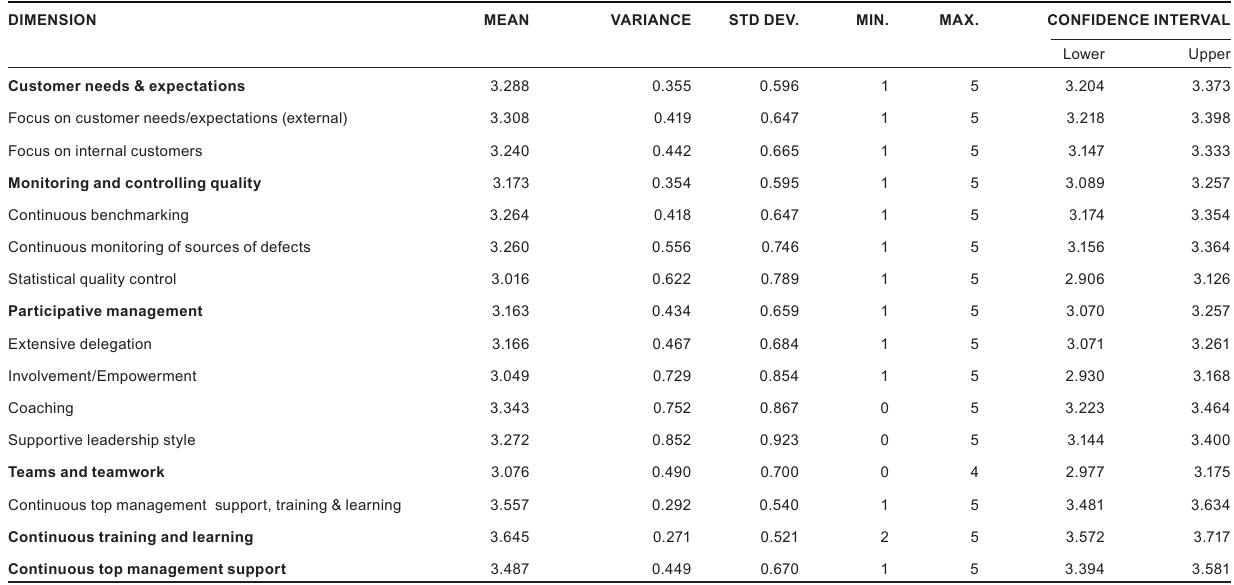
Table 3 Descriptive statistics: Key dimensions of